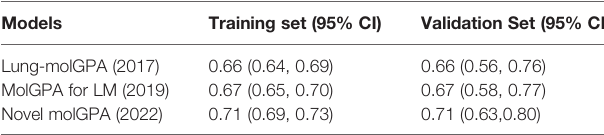
TABLE 4 | Concordance results of three GPA models.